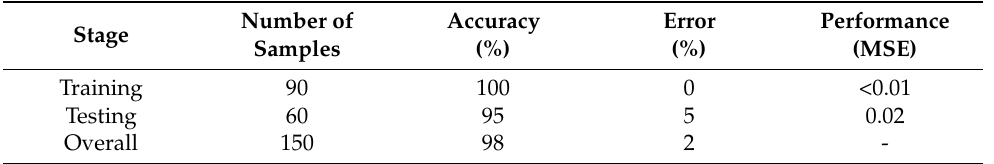
Table 4. Statistical results for the artificial neural network pattern recognition model developed. Performance is based on the mean squared error (MSE).